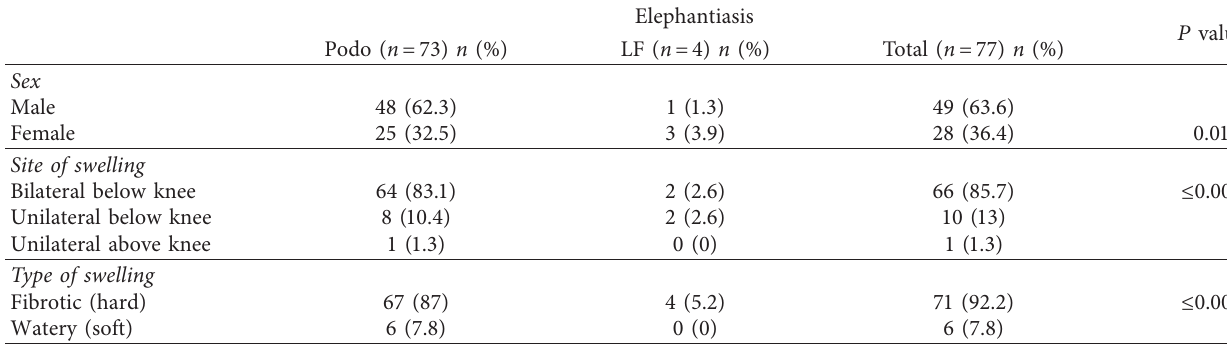
Table 2: Type and sites swelling of elephantiasis cases ( n � 77) in Jeldu district, West Shoa, Ethiopia.